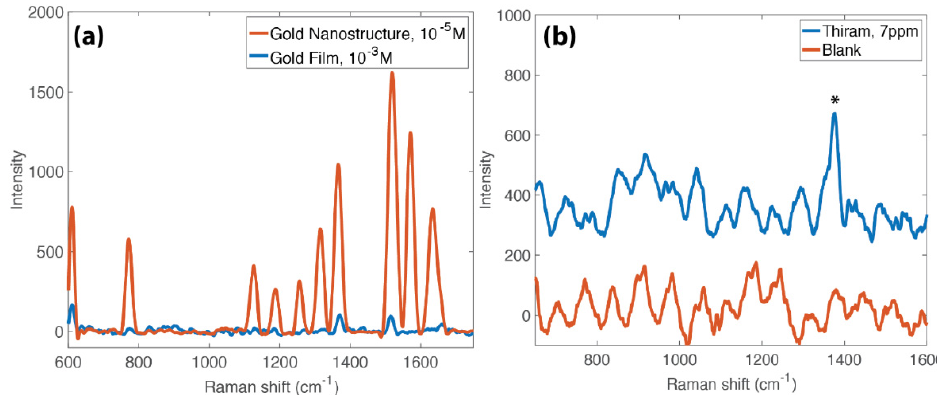
Figure 4. Chemical detection on the nanostructures. ( a ) Rhodamine 6G Raman spectra on a gold nanostructure (red) and a gold film (blue). These spectra are used to determine the surface enhanced Raman scattering (SERS) enhancement factor of 1.5 × 10 3 . ( b ) Chemical detection of thiram on the nanostructures at a concentration of 7 ppm. The key peak at 1385 cm − 1 is identified with an asterisk. Note that the oscillatory background in part ( b ) is an artifact of the notch filter.